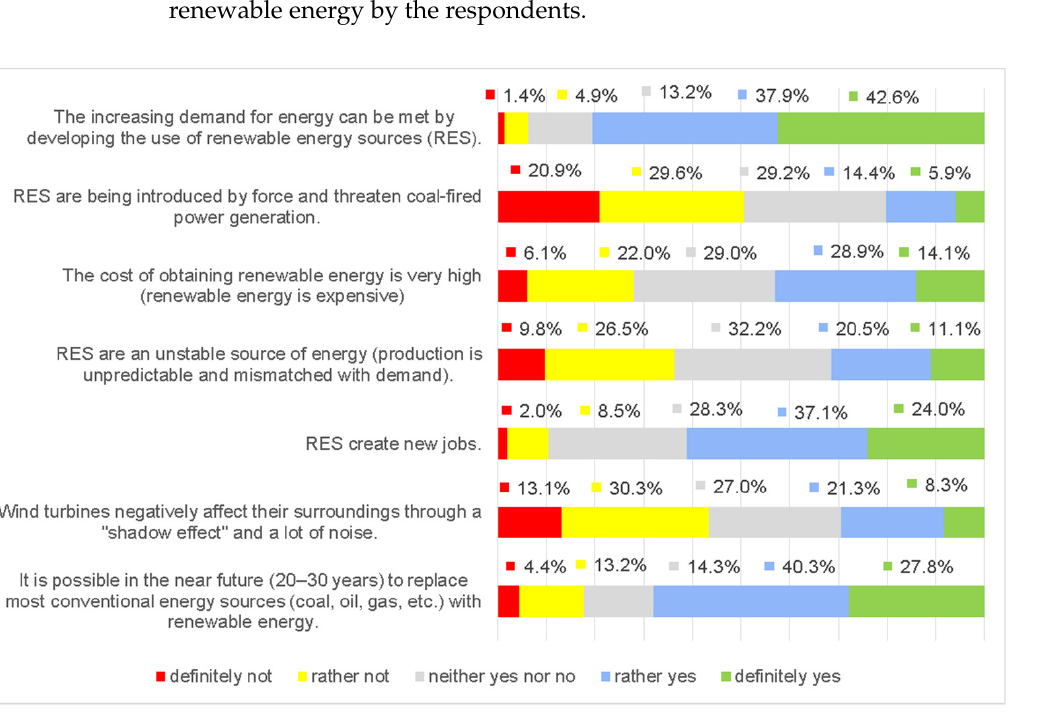
Figure 6. Structure of the assessment of theses diagnosing the perception of renewable energy sources by respondents.